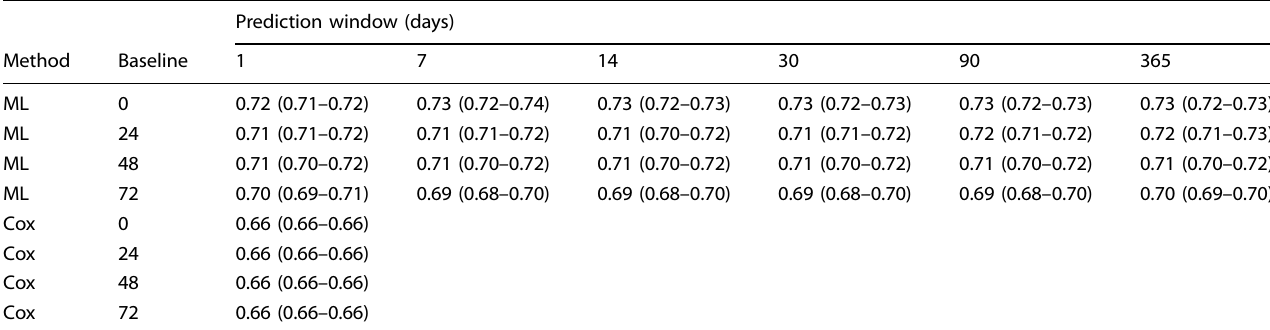
Table 2. Comparison of the discriminative ability for machine learning (ML) based versus conventional Cox proportional-hazard models with baseline 0, 24, 48, and 72 h, respectively, after ICU admission.